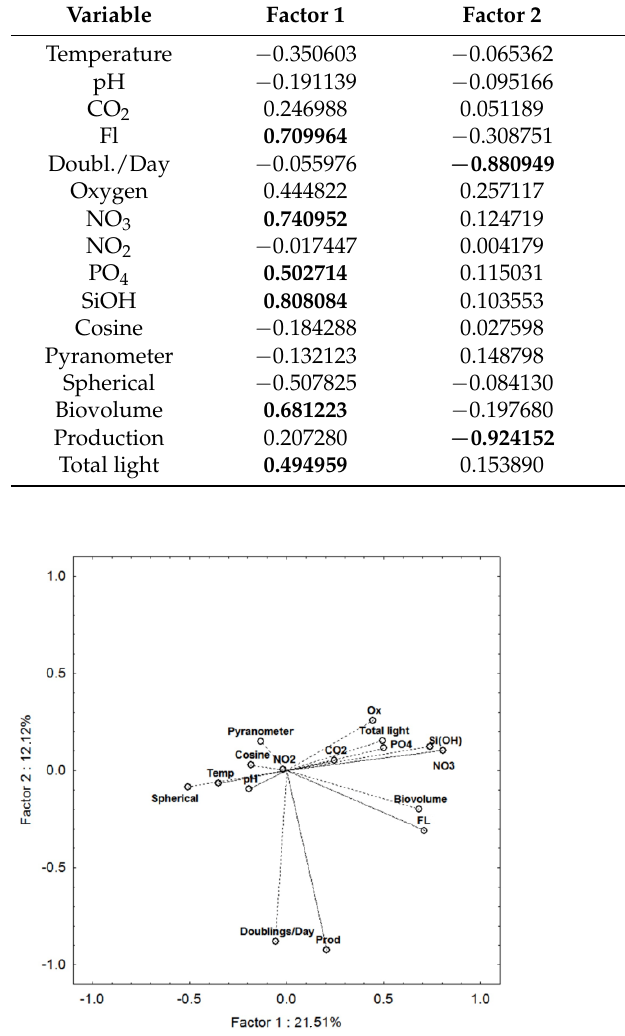
Table 5. PCA factor loadings from variable correlation matrix for four first factors in analysis of data (matrix since 16 cases × 206 active cases). Bold shows significant (5 %) loadings.